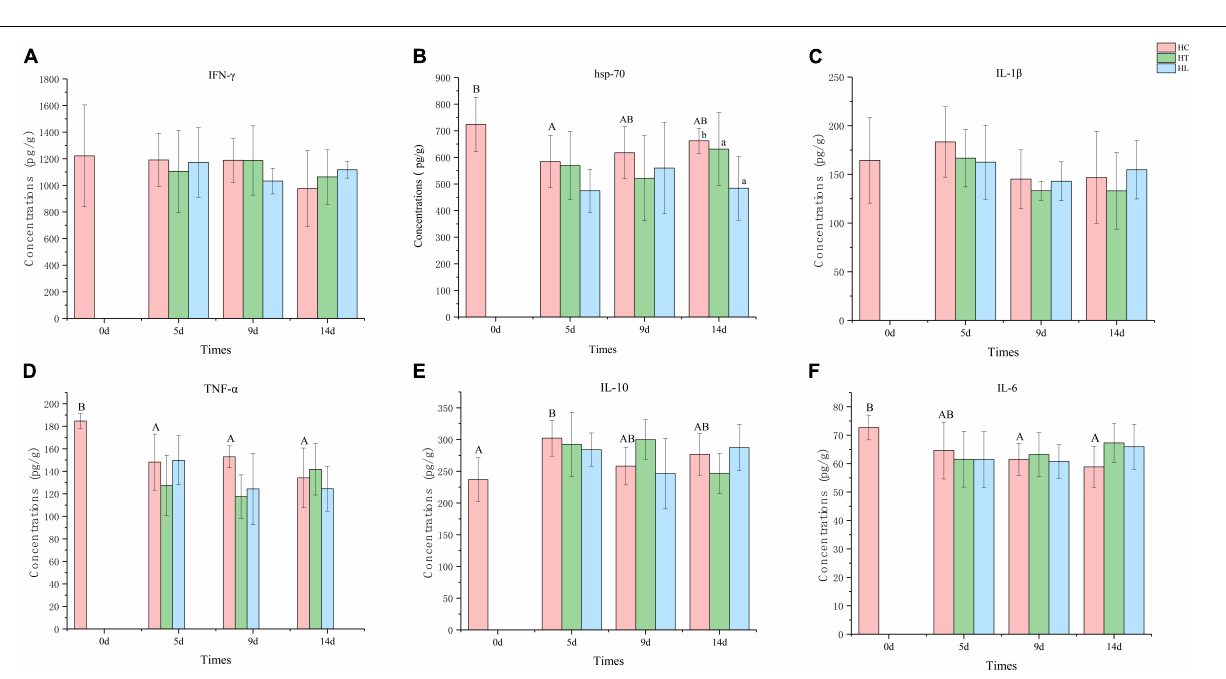
Frontiers in Microbiology |